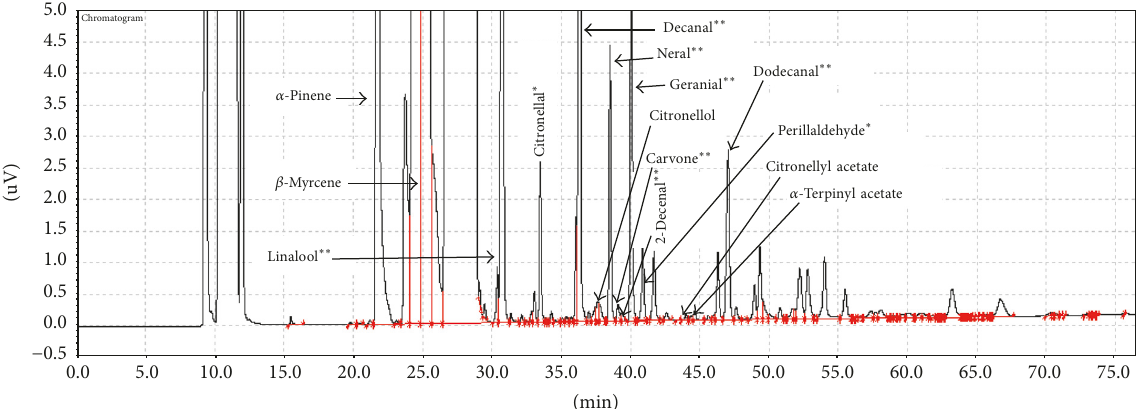
Figure 5: Chromatogram from Valencia Early Asymptomatic. Note . While 2,4-decadienal was quantifiable in this sample, it was not labeled on the chromatogram as the peak is too small to be seen. ∗ Compound has lower concentration compared to VES. ∗∗ Compound has higher concentration compared to